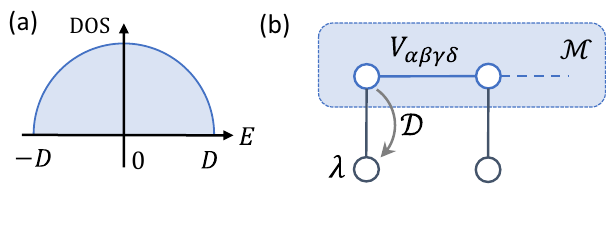
Fig. 1 Model setup. a The noninteracting density of states (DOS) of the degenerate multi-band Hubbard-Hund lattice model on the Bethe lattice has a semicircular shape. b ( M ; M ) site impurity model with M -fold degenerate correlated orbitals coupled with M bath orbitals. The interactions among the physical orbitals are speci fi ed by the Coulomb matrix V . Due to symmetry, each physical orbital (positioned at zero energy level) is coupled with a single bath orbital at energy level λ with a coupling parameter D . The models with M ¼ 2 and 3 correspond to that of e g and t 2 g orbitals in cubic crystal employs a quantum computer to fi nd the ground state energy and